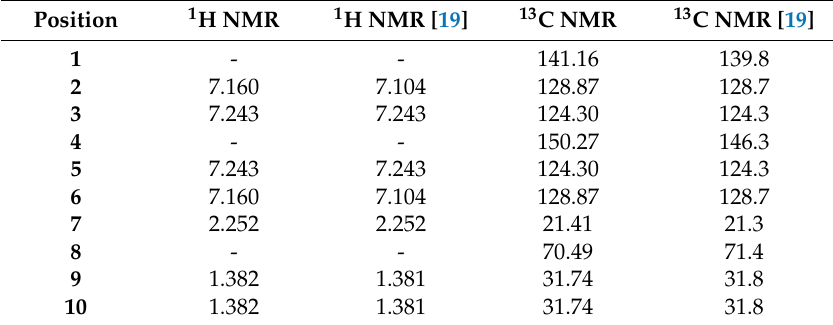
Table 5. NMR data of p -cymen-8-ol substance (S 21) compared to literature data. Position